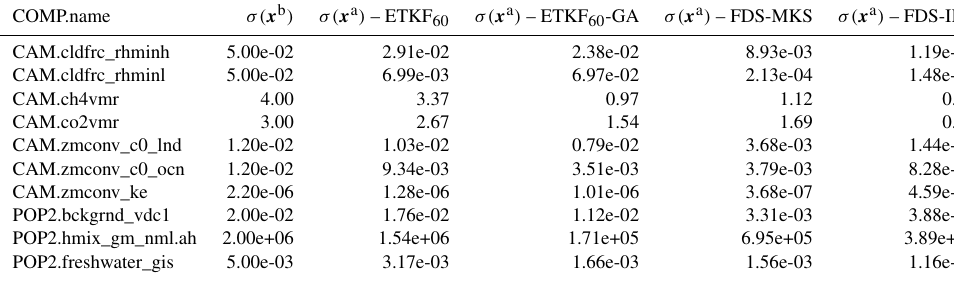
Table B2. CESM posterior standard deviation in control variables 1 .